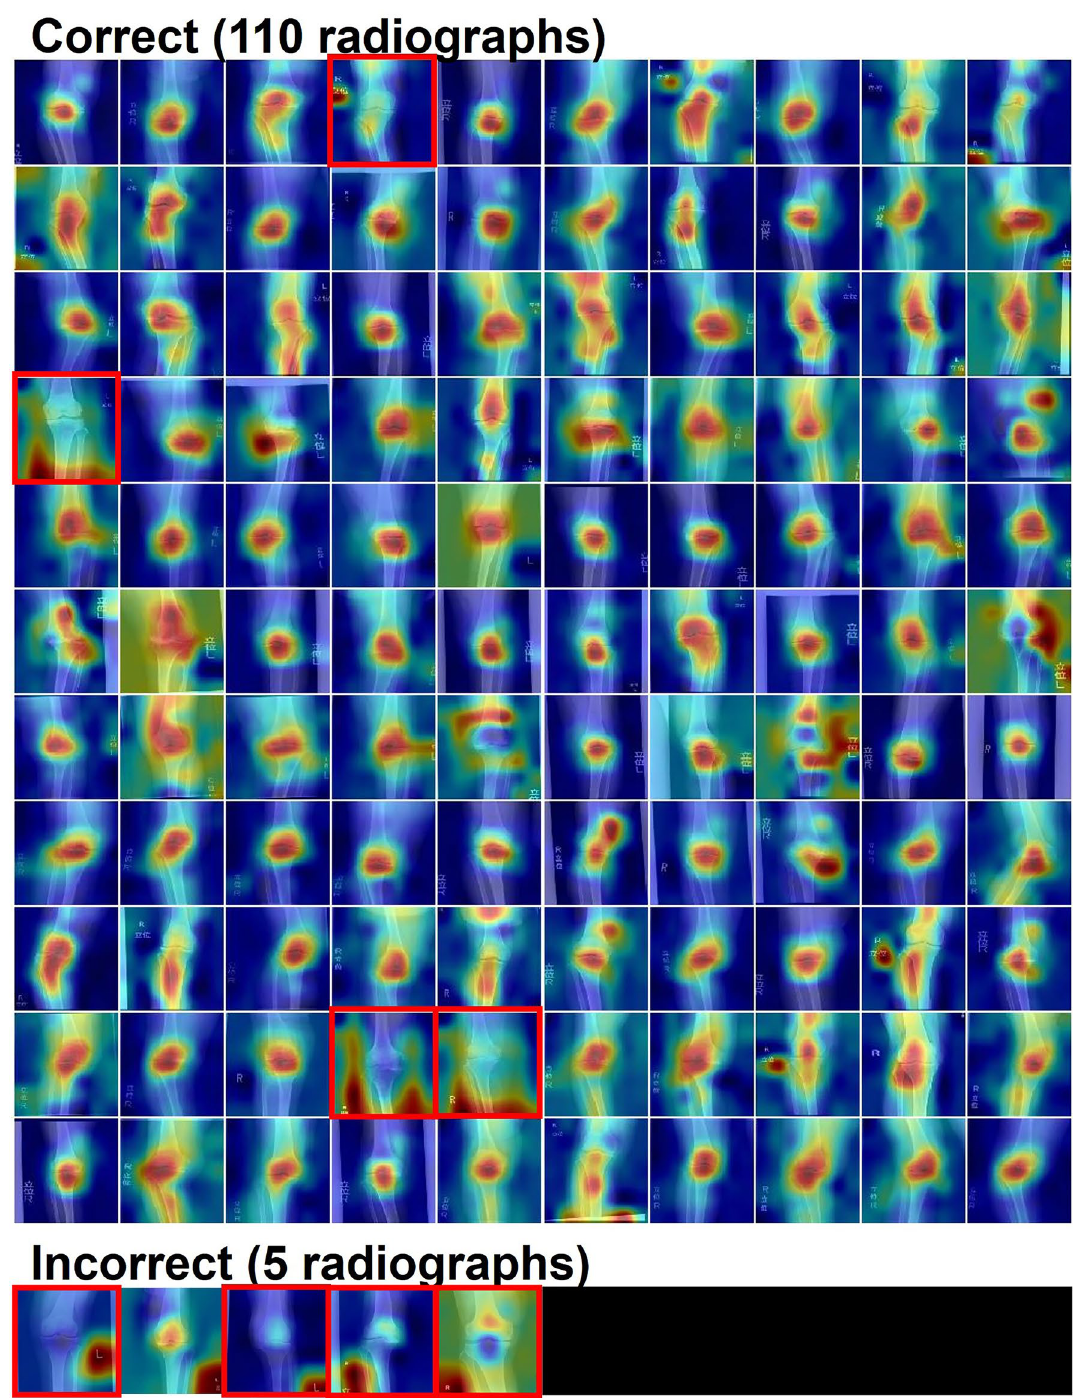
Figure 2. Validation of the model with Grad-CAM on the datasets containing 115 radiographs of primary osteoarthritis. The red-colored region in the heatmap demonstrates the area with high contributed to the classification by the model. In 93.0% (107/115) radiographs, the class-discriminating area included joint areas. Eight radiographs where the class-discriminating area did not include joint area were surrounded by red rectangles. Correct; radiographs which were correctly classified as ‘OA’, Incorrect; radiographs which were incorrectly classified as